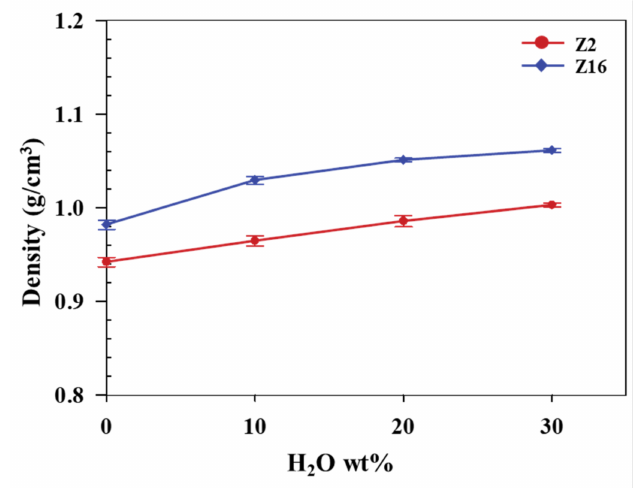
Figure 2. Z2 and Z16 densities as functions of H 2 O